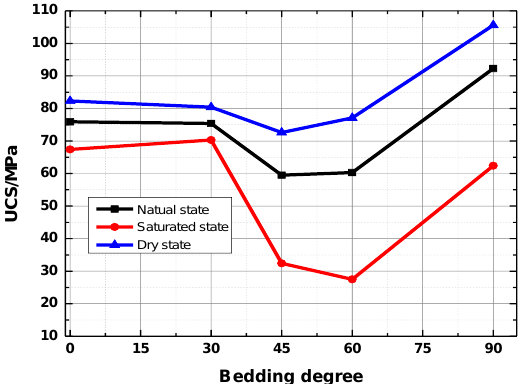
Figure 8. The relationship of bedding angles and uniaxial compressive strength.